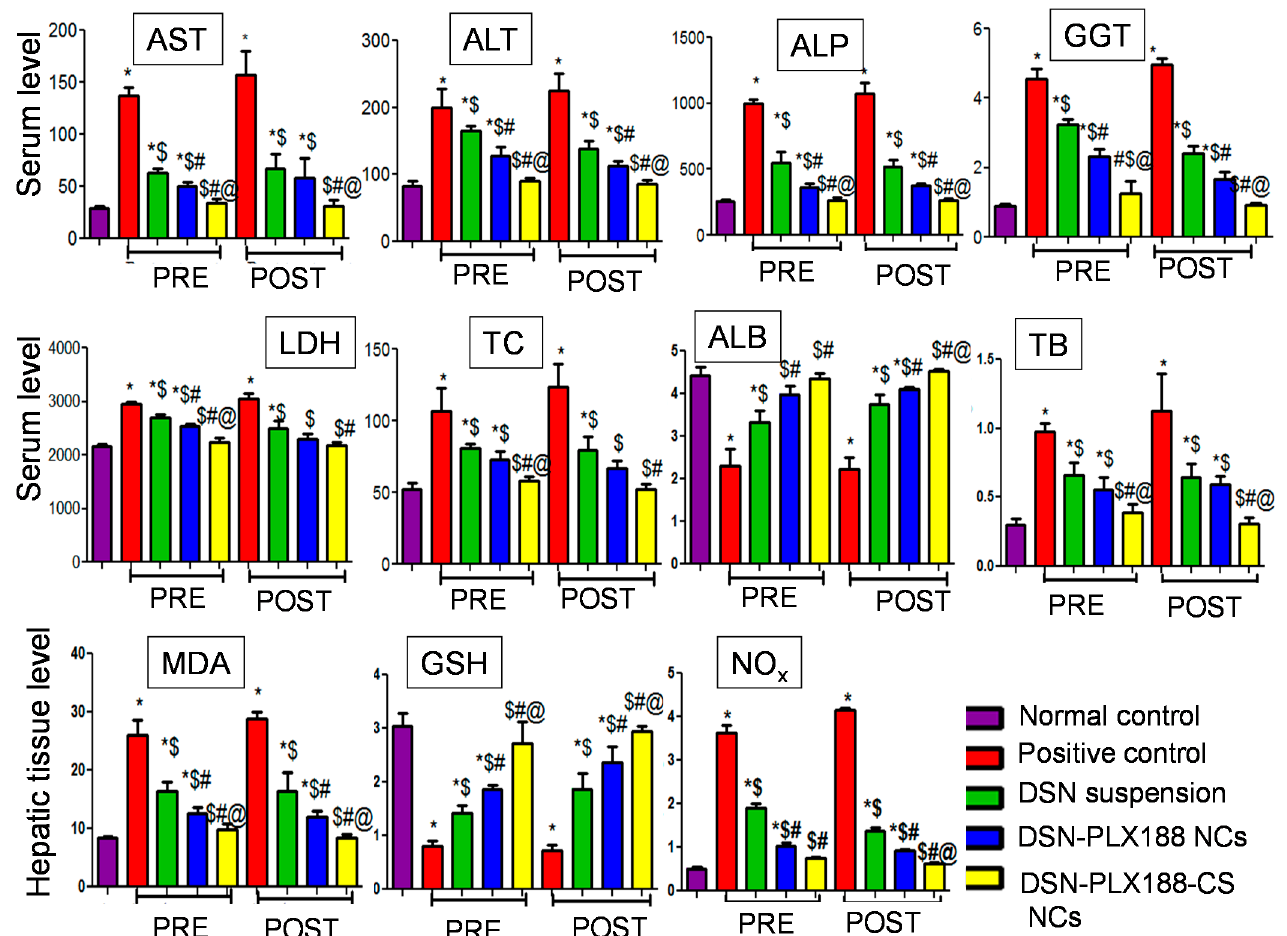
Figure 6. The serum/hepatic tissue levels of the examined biomarkers following the pretreatment (PRE) and the post- treatment (POST) regimens. Data are expressed as the mean ± SD ( n = 6). The statistical analysis was performed at p < 0.05. *, $, # and @ indicate significant differences. * vs. the normal control. $ vs. the positive control. # vs. DSN-suspension-treated group. @ vs. DSN–PLX188-NC-treated group. AST, aspartate aminotransferase; ALT, alanine aminotransferase; ALP, alkaline phosphatase; GGT, gamma glutamyl transferase; LDH, lactate dehydrogenase; TC, total cholesterol; ALB, albumin; TB, total bilirubin; MDA, malondialdehyde; GSH, reduced glutathione; NO x , nitrate/nitrite production.